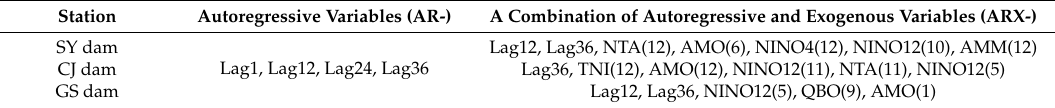
Table 3. The two types of input variables for the three dams.